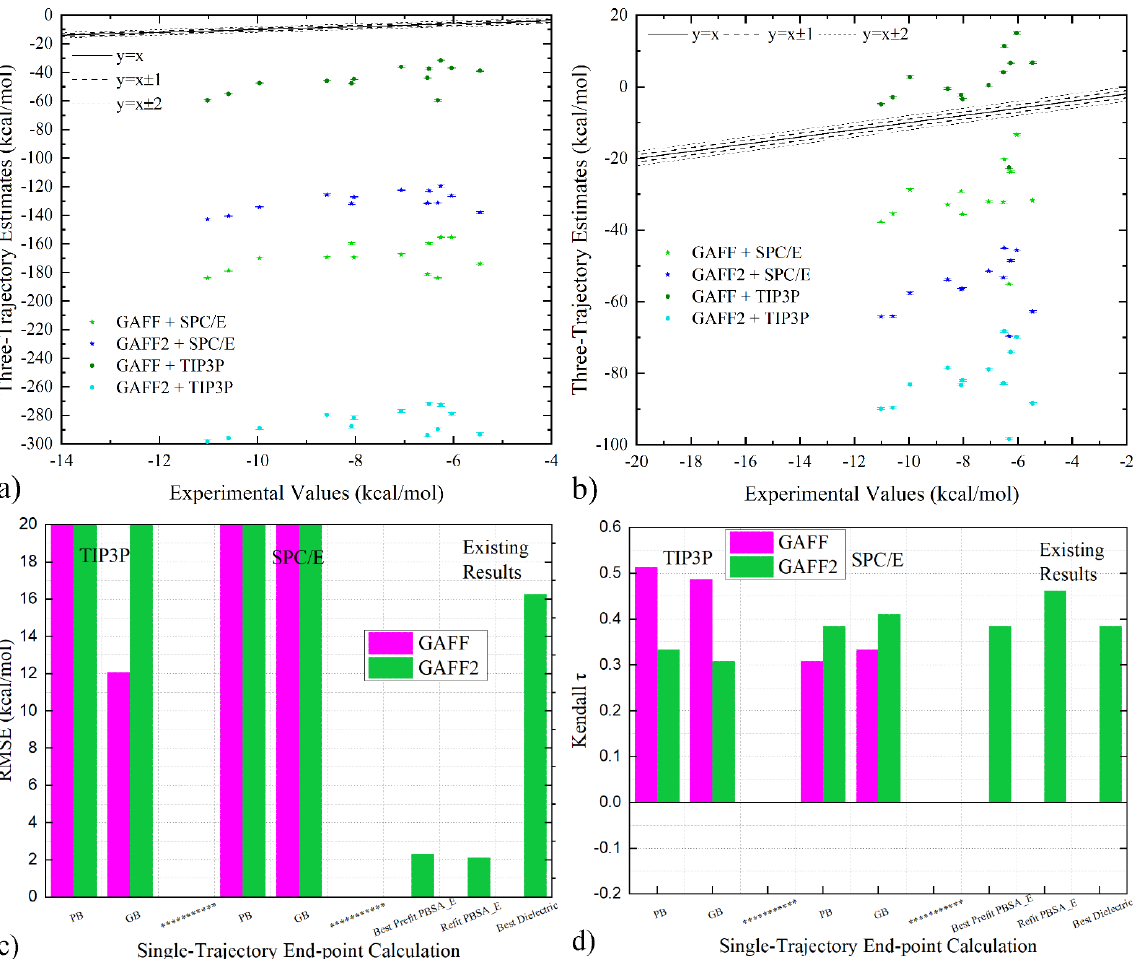
Figure 3. Correlation of three-trajectory estimates and experimental reference under GAFF and GAFF2 with ( a ) PB and ( b ) GB implicit solvent treatment. ( c , d ) Comparison between quality metrics of three-trajectory end-point estimates under GAFF and GAFF2. Three existing estimates obtained from modified end-point procedures reported in our previous works are also provided (specifically PBSA_E scoring functions pre-fitted with protein–ligand data and refitted with WP6-specific experimental data and the dielectric constant-variable regime).